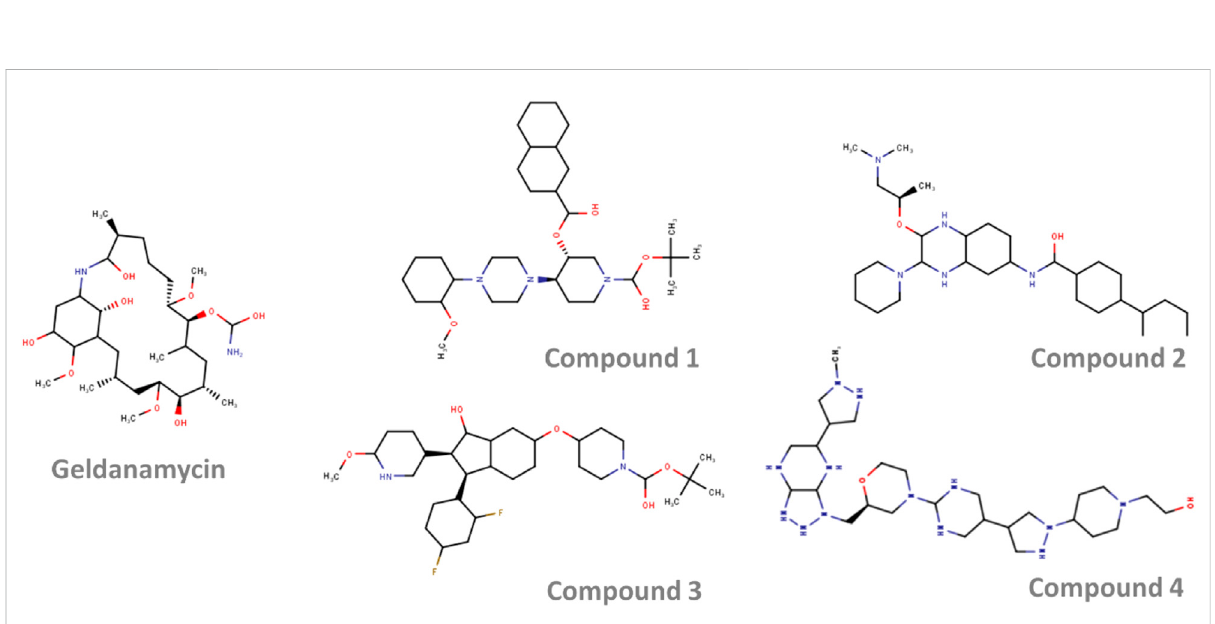
FIGURE 4 The 2-dimensional structure of the top four selected molecules in